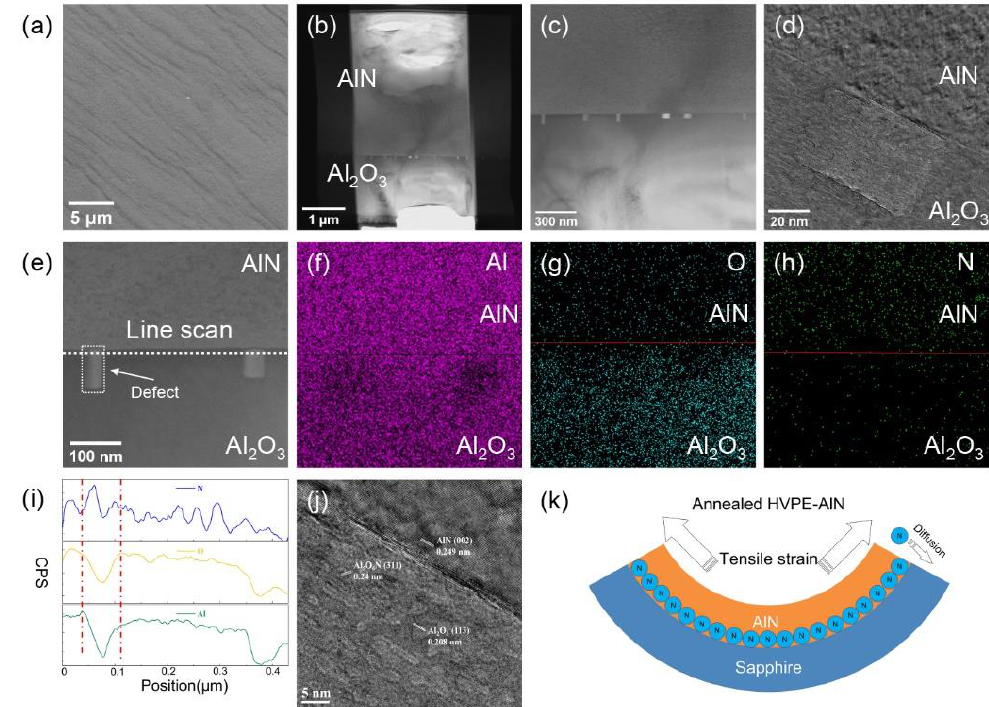
Figure 4. ( a ) SEM image of the surface of an AlN sample annealed at 1700 °C under a magnification of 8000 times; ( b ) STEM image of a cross section under a magnification of 35,000 times; ( c ) STEM image of defects at the AlN/sapphire interface; ( d ) HRTEM image of a single rectangular defect; ( e ) TEM-EDS surface scan at the defect; ( f ) EDS result of Al; ( g ) EDS result of O; ( h ) EDS result of N; ( i ) EDS line scan; ( j ) single defect schematic diagram of element calibration; ( k ) schematic diagram of N diffusion.